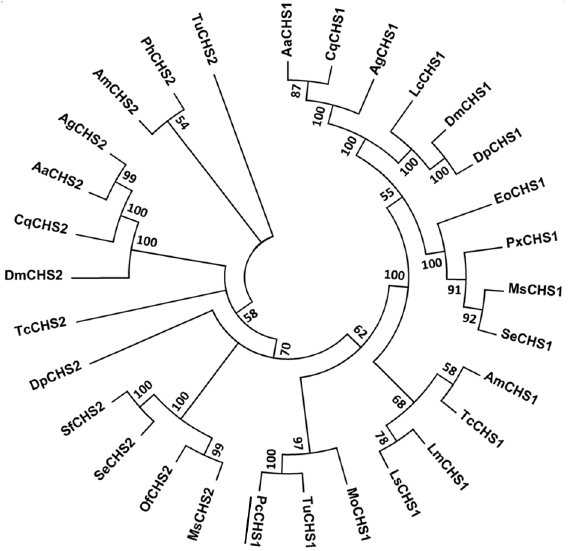
Figure 3. Phylogenetic analysis between the chitin synthase 1 gene, PcCHS1 , from the citrus red mite, Panonychus citri (Acari: Tetranychidae), and the known acari and insect chitin synthase genes. The phylogenetic tree was constructed by MEGA 5.04 based on the neighbor-joining method according to amino acid sequences. Bootstrap support values with 1000 are shown on the branches. The chitin synthase sequences used to generate the tree are listed in Table 1.